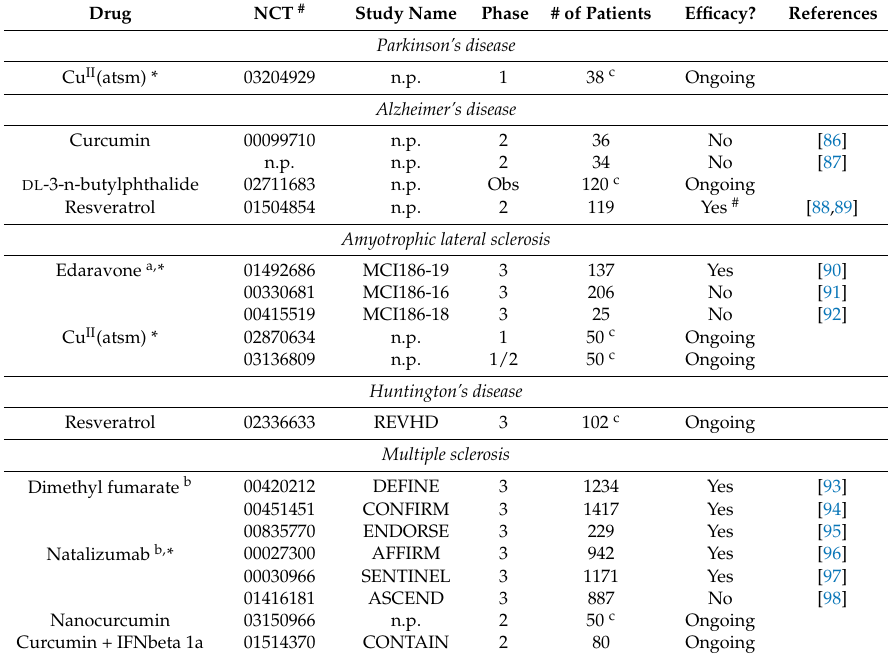
Table 2. Clinical trials involving Nrf2 inducers for neurodegenerative